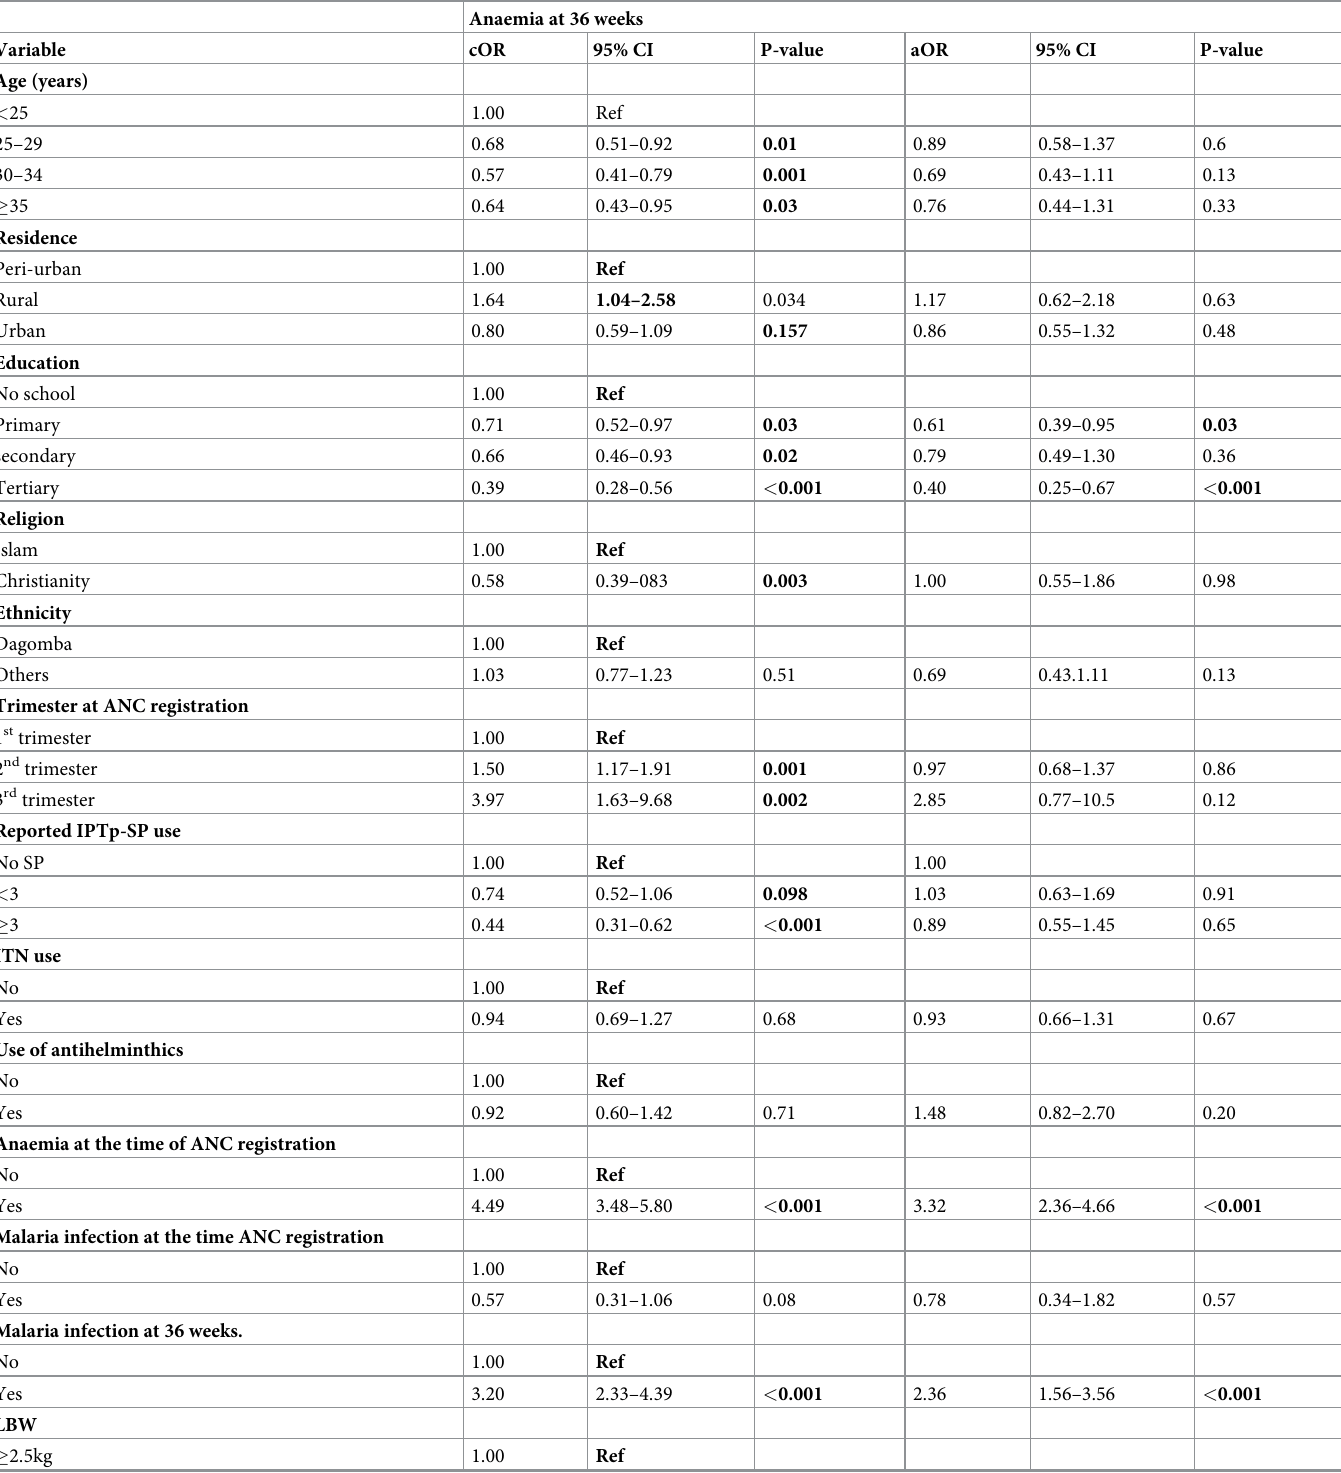
Table 3. Multivariable logistic regression of risk factors and anaemia in